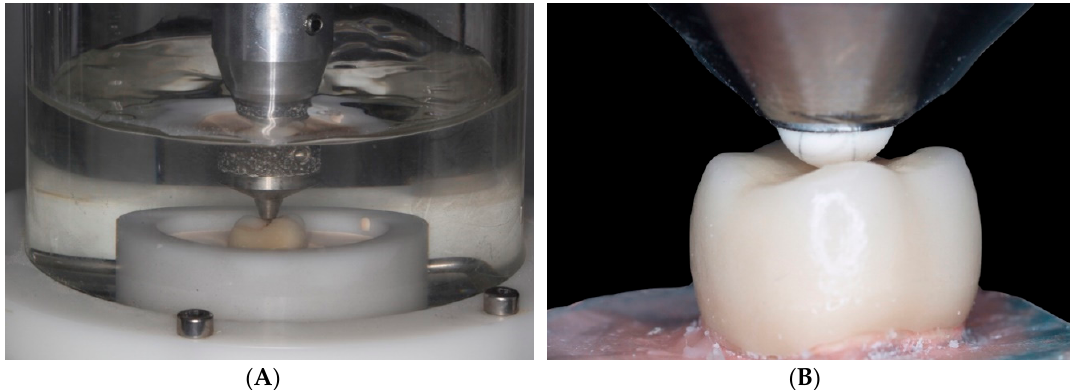
Figure 2. In vitro fracture resistance testing of crowns. ( A ) Dynamic compression fatiguing (Chewing Simulator CS-4 SD Mechathronik); ( B ) Static compression testing until fracture with SHIMADZU® universal test machine.